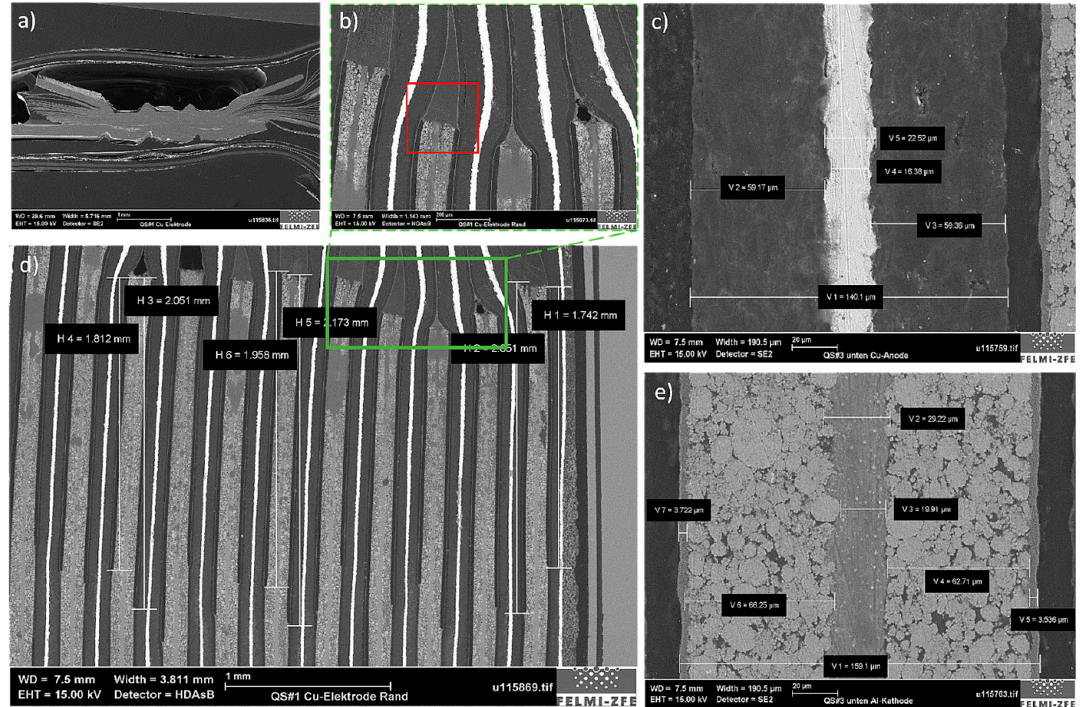
Figure 7. Imaging results of Sample #1, generated at the anode tab. ( a ) All copper current collectors extended to the tab area, where they were point-welded; ( b ) additional separator layer was measured from the beginning of the cathode layer with ( d ) a length of about 2 mm. ( c ) Measured anode and ( e ) cathode thicknesses from the stacked layer sample.